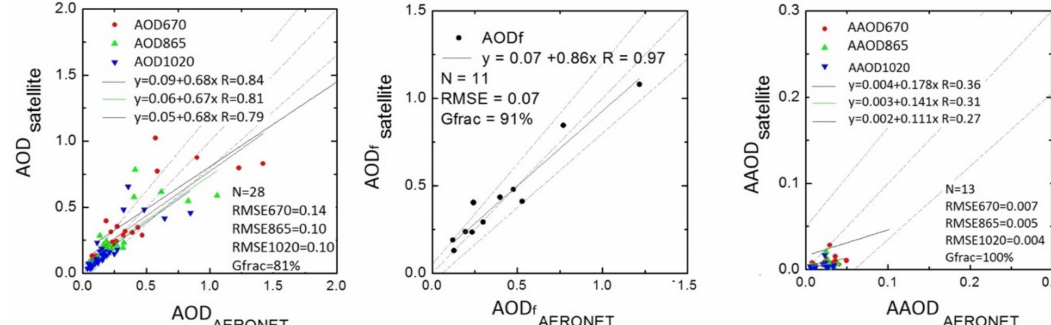
Figure 7. The comparison of aerosol optical properties AOD retrieved in this study from POLDER-3/PARASOL and AOD provided by AERONET for three AERONET sites located in North China Plain during the period January 2012. Red points represent the 670 nm, green points represent the 865 nm and blue points represent the 1020 nm. N is the total number of results. The dotted lines are the expected error lines (EE = ± (0.05 +